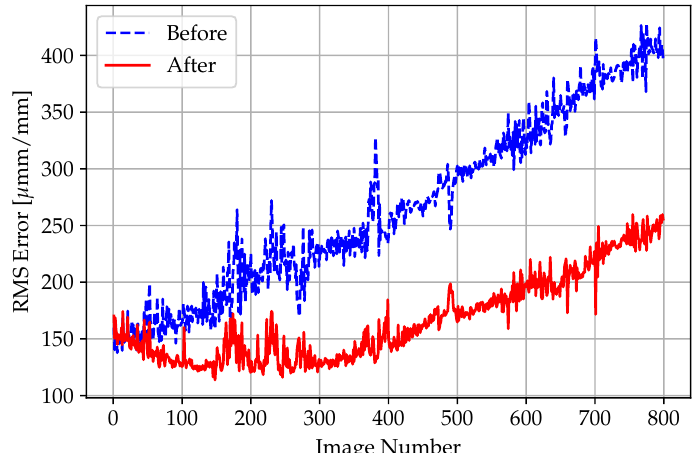
Figure 14. The RMS strain error between the stereo-DIC and 2D-DIC measurements, before and after the error compensation was applied, for Test 2.